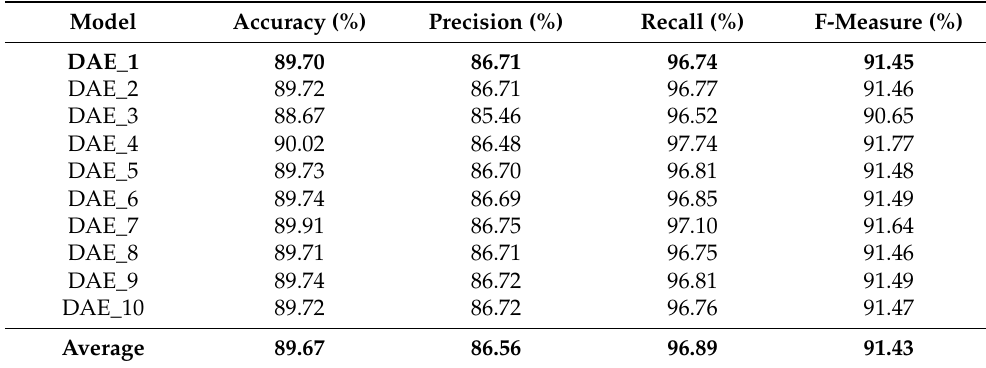
Table 7. Experimental results of the DAE using the NSL-KDD test dataset as a